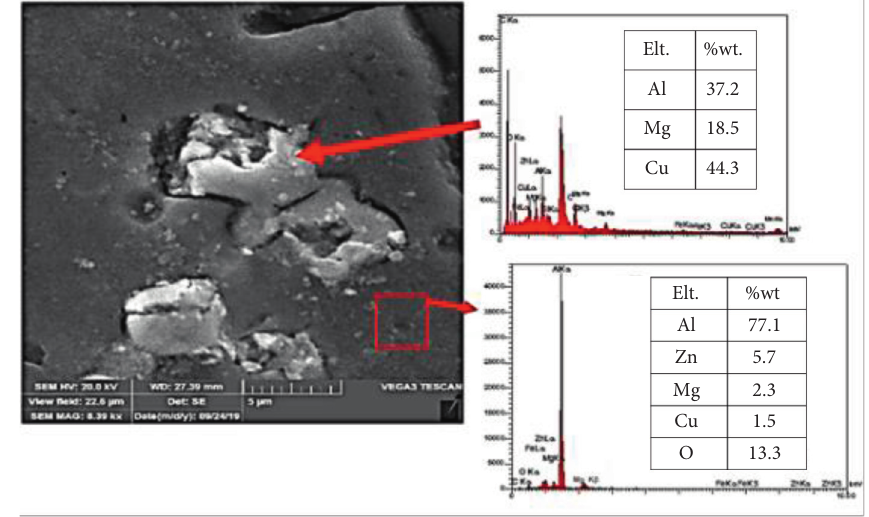
Figure 8: SEM& EDS results of grain boundary precipitation (sample